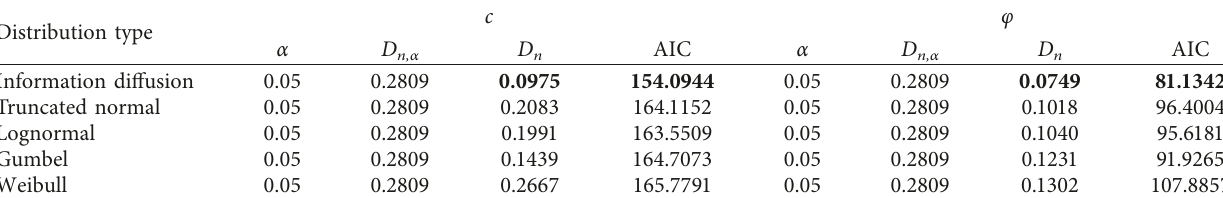
Table 4: Goodness-of-fit test for different marginal